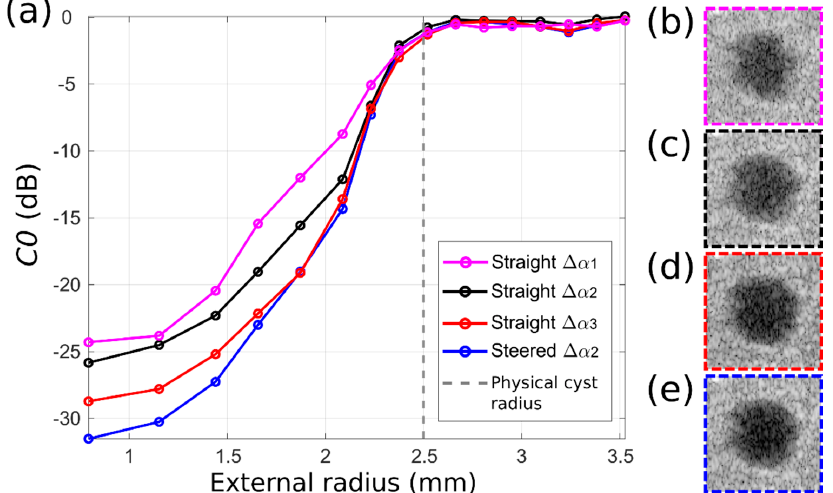
Figure 9. ( a ) Curves of the contrast 𝐶0 (cid:3031)(cid:3003) (defined by equation (9)) plotted as a function of the external radius of each ring for Hole 1 and for different angular sampling periods. The angular periods are Δ α 1 ≈ 8°, Δ α 2 ≈ 4°, and Δ α 3 ≈ 2°; ( b – e ) xz-images of Hole 1 at y = 0 for the different ac- quisition modes: ( b ) straight Δ α 1 , ( c ) straight Δ α 2 , ( d ) straight Δ α 3, and ( e ) steered Δ α 2 . The images are displayed with − 60-dB dynamic range. 0 for the different acquisition modes: ( b ) straight ∆ α and ( e ) steered ∆ α 2 . The images are displayed with − 60-dB dynamic